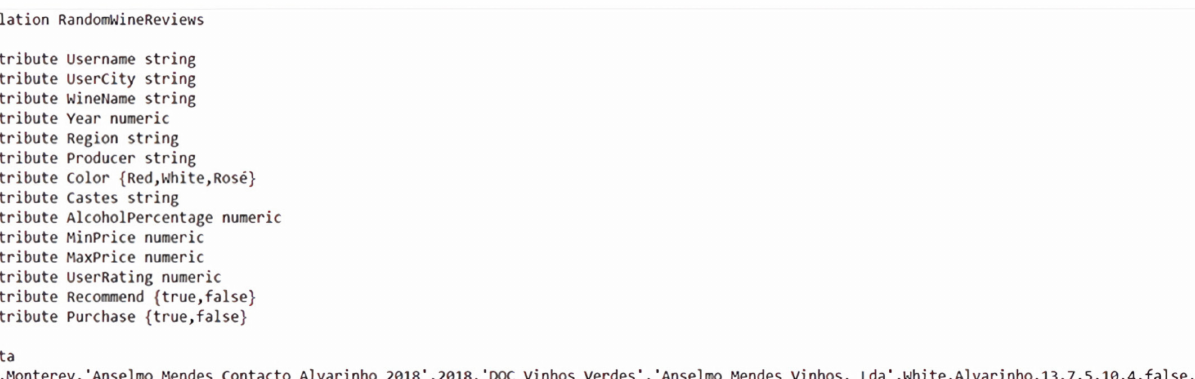
Figure 3. ARFF file